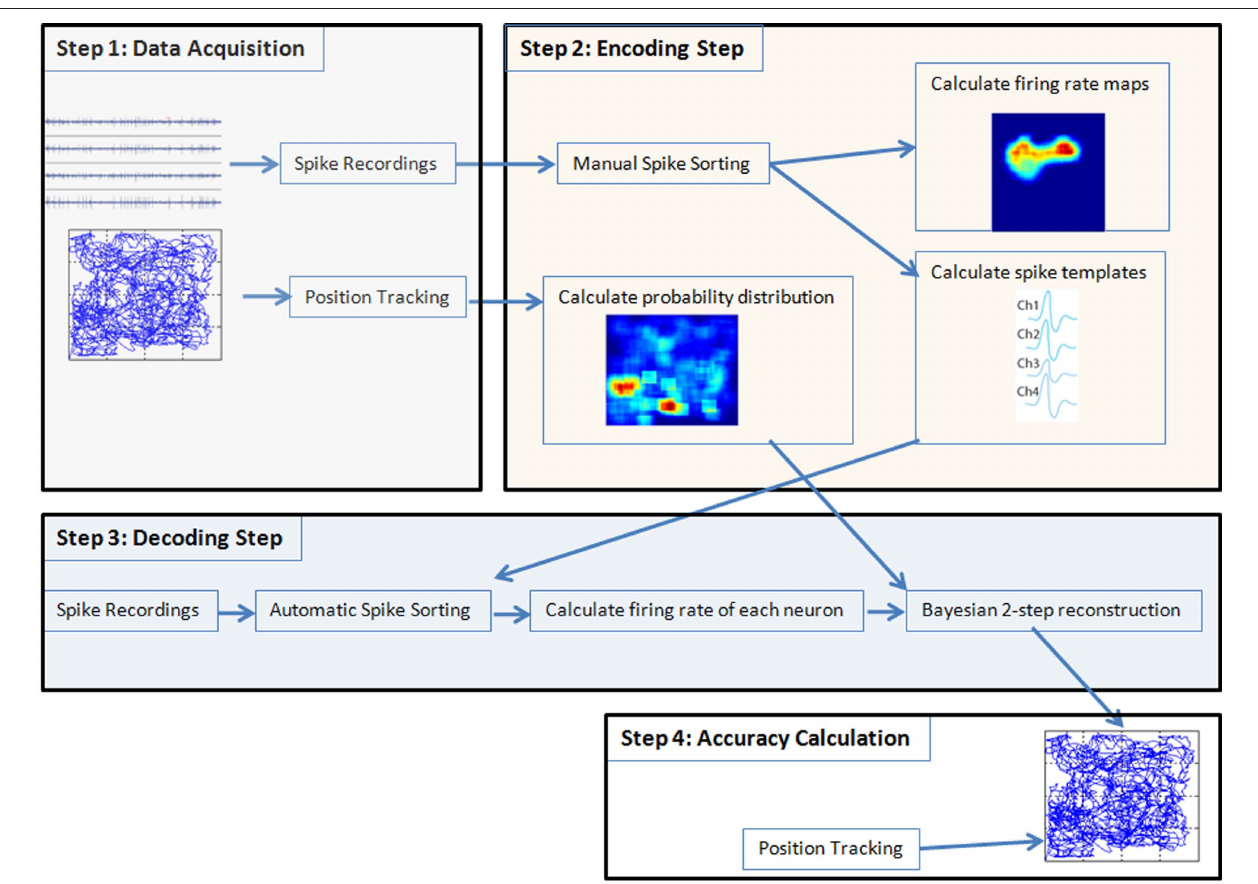
together with the probability distribution of position and with the firing rate maps into the Bayesian two-step algorithm. The Bayesian two-step algorithm returns the reconstructed position and was compared to the position coming from the tracking system to calculate the overall accuracy of the reconstruction procedure. In real-time mode instead of splitting the data in 50% parts, one run was performed for the encoding and later on another run was performed for the real-time decoding step.